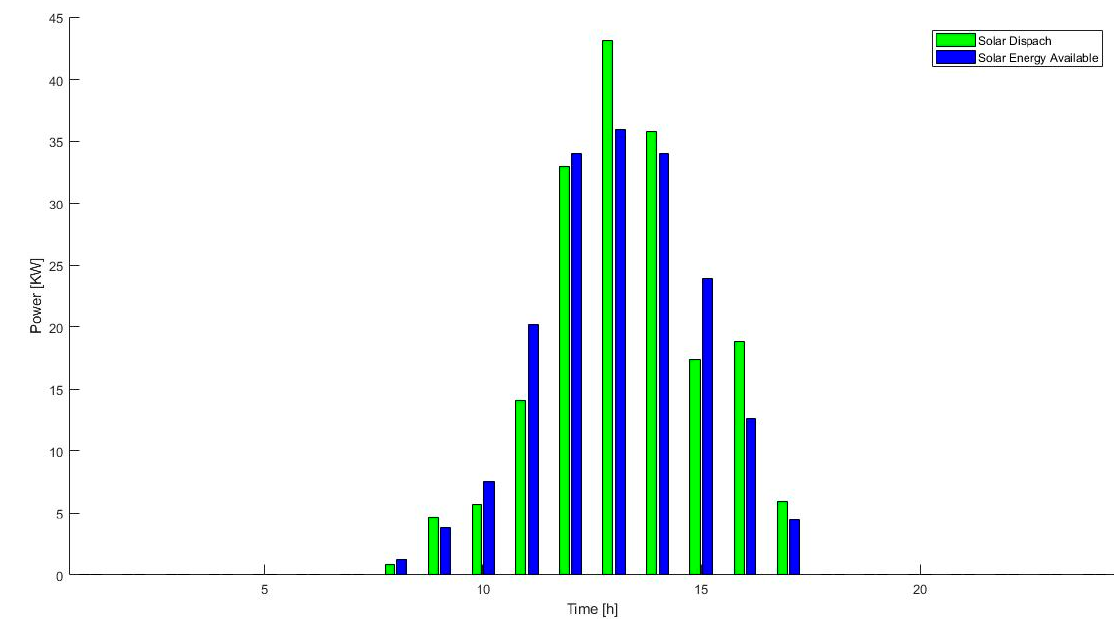
Figure 8. Availability and dispatch of the solar energy system of the MG when the storage system is after the 60% of its useful life.